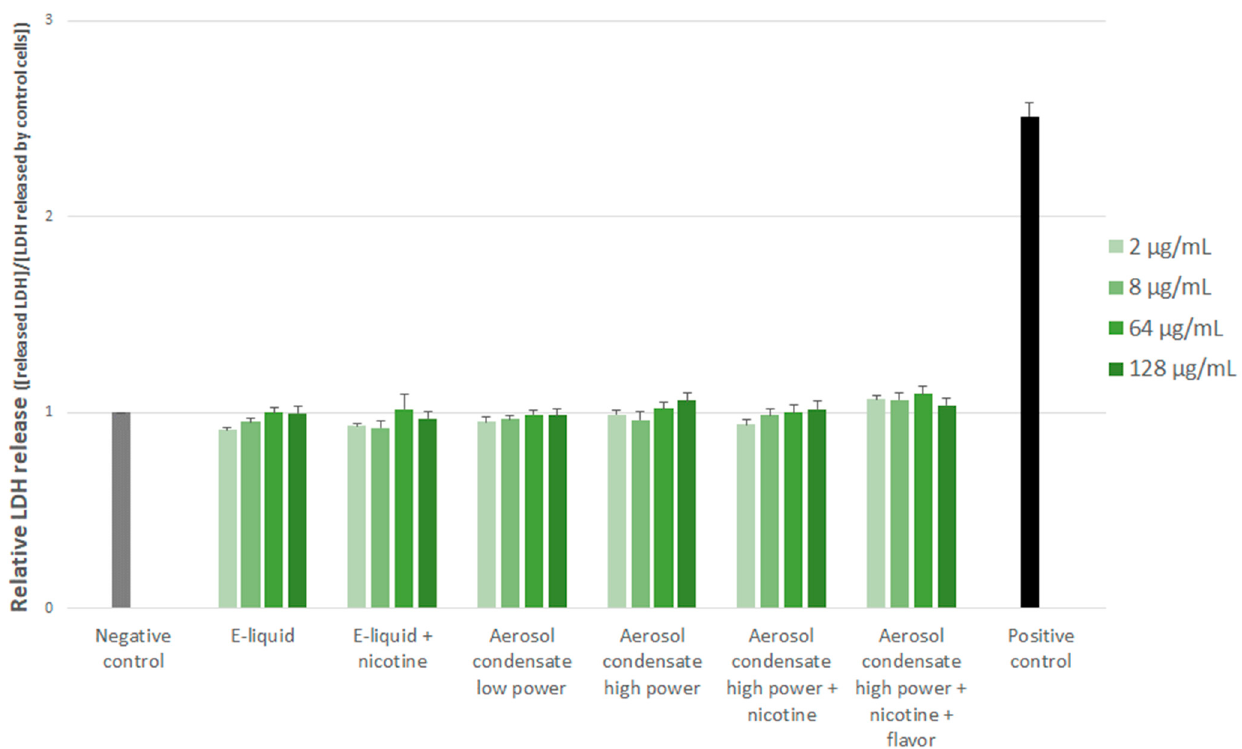
Figure 2. Relative cytotoxicity induced by the different experimental conditions assessed after 24 h of cell exposure by the LDH release. Results are expressed relative to control (unexposed) cells and are means of three independent experiments, each performed in duplicate.